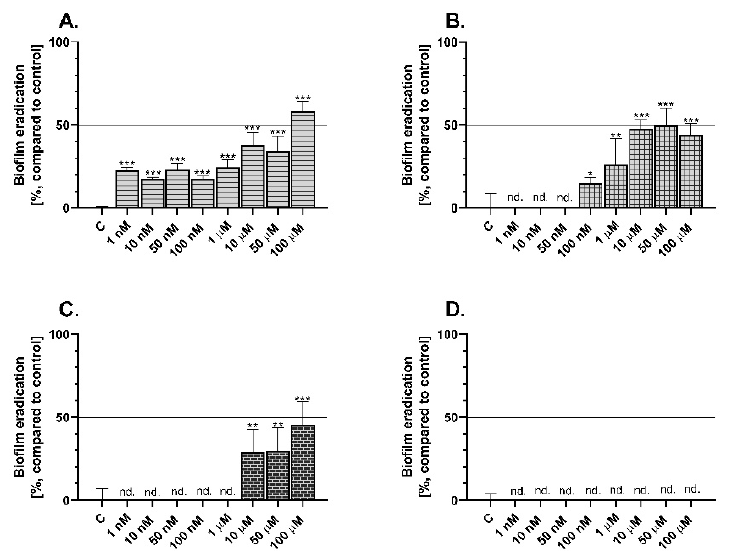
Figure 6. Pseudomonas aeruginosa -based biofilm eradication after 24 h treatment with Les-3166 ( A ), Les-5935 ( B ), Les-6009 ( C ), and Les-6166 ( D ). Mean values ( n = 6) with standard deviation (error bars) where *, **, and *** are statistically different from the respective (vehicle-treated) control at p < 0.05, p < 0.01, and p < 0.001, respectively (one-way ANOVA, Tukey’s test); nd—no changes in biofilm eradication were detected, in comparison to the control denoted as “C”.